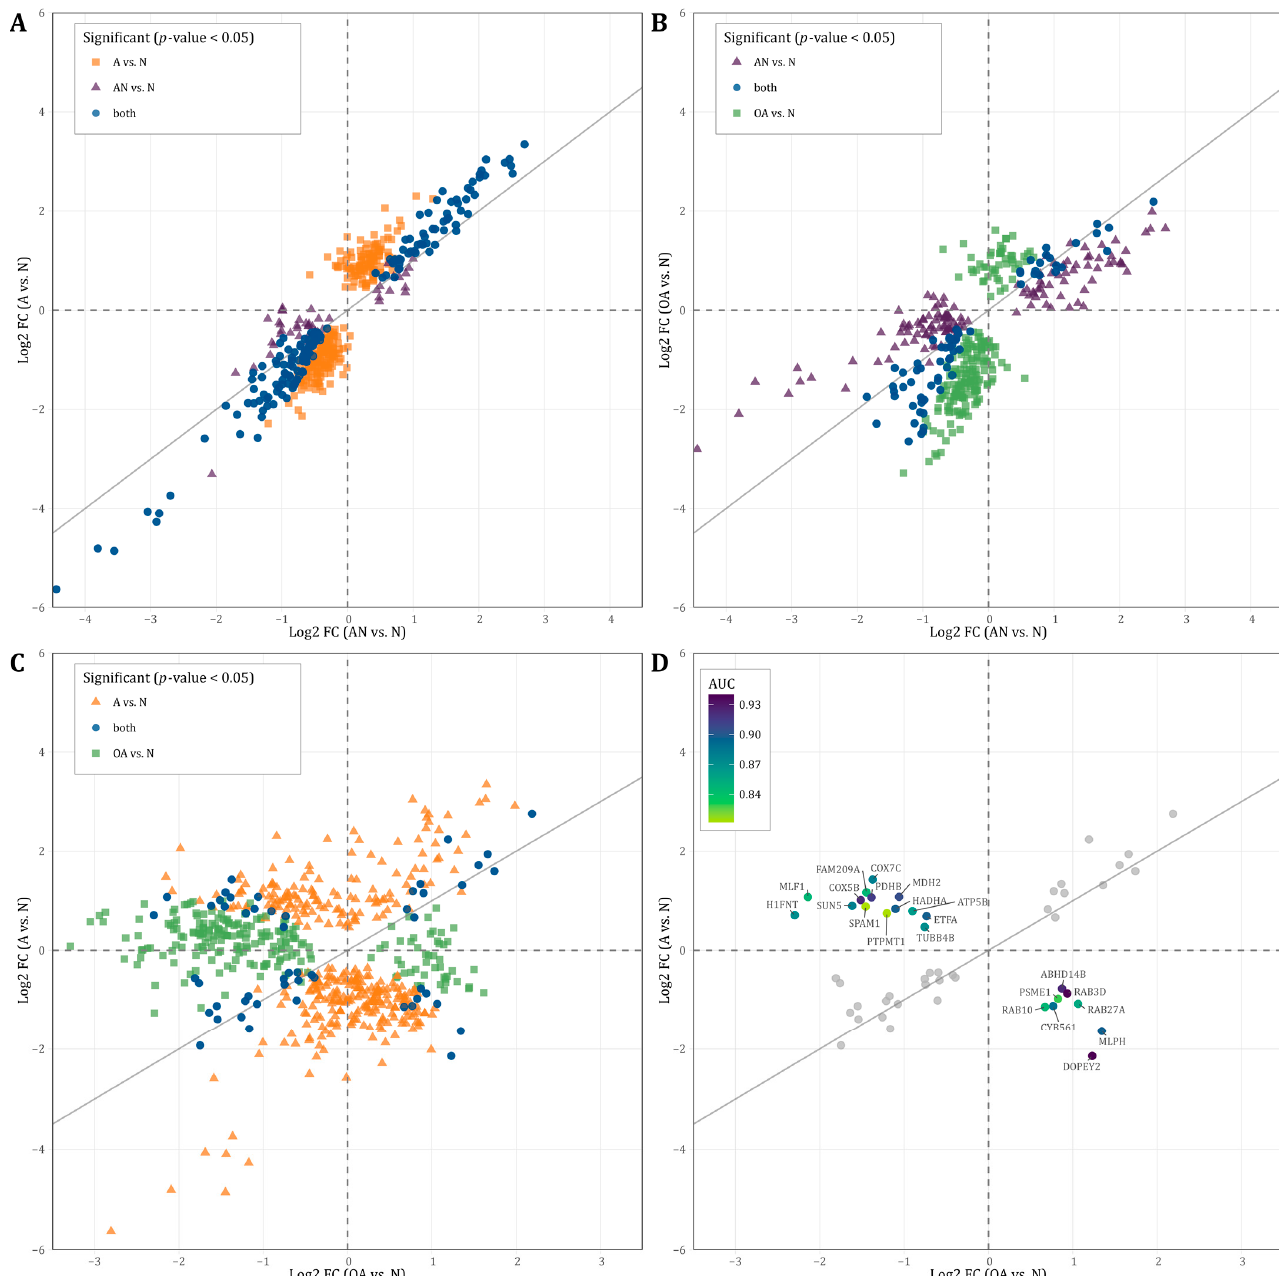
Figure 4. ( A – C ): Scatterplot displaying the direction of regulation (log2 fold change) of proteins that showed significantly different abundance levels ( p -value < 0.05) in the ( A ): AN vs. N and/or OA vs. N, ( B ): AN vs. N and/or A vs. N, and ( C ): A vs. N and/or OA vs. N. ( D ): Scatterplot displaying the direction of regulation (log2 fold change) of proteins that showed significantly different abundance levels ( p -value < 0.05) in both A vs. N and OA vs. N. The color represents the area under the curve (AUC) value of proteins that were oppositely regulated.